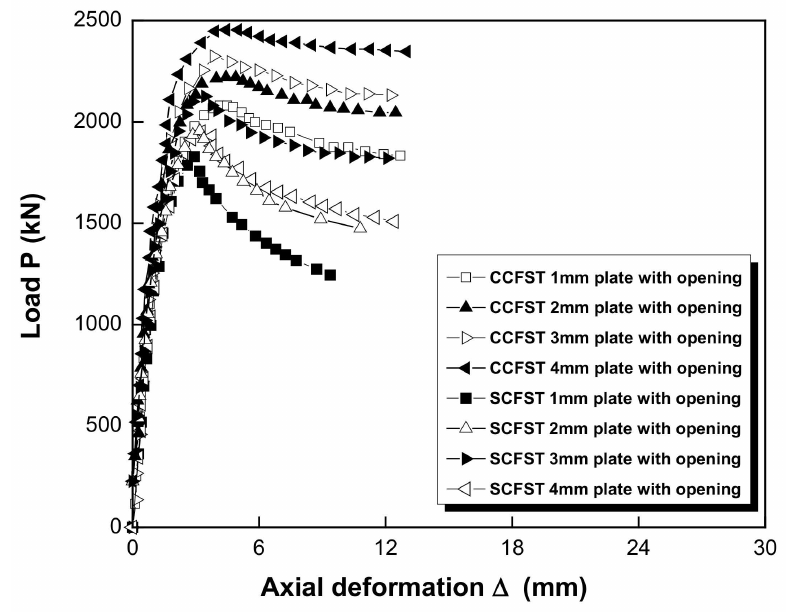
Figure 13. Axial load (P)-axial deformation ( ∆ ) of CCFST and SCFST models different cross-shaped plates with